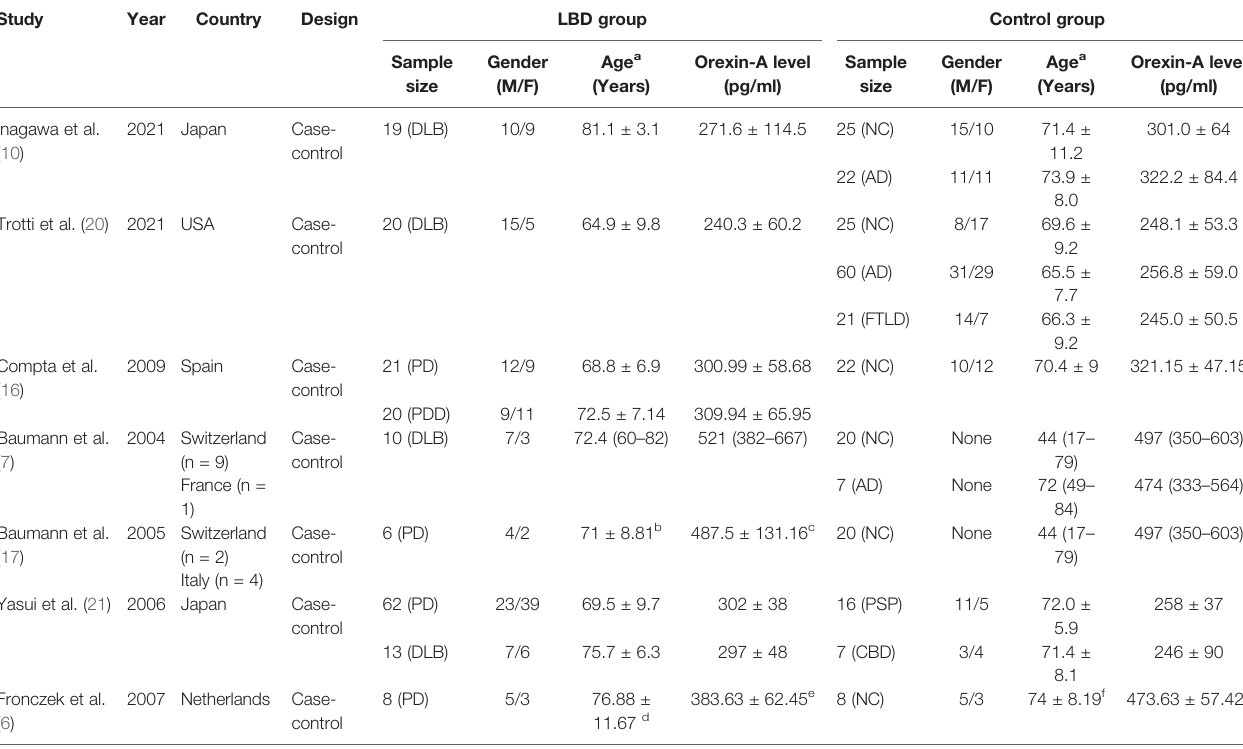
TABLE 1 | Characteristics of seven case-control studies included in